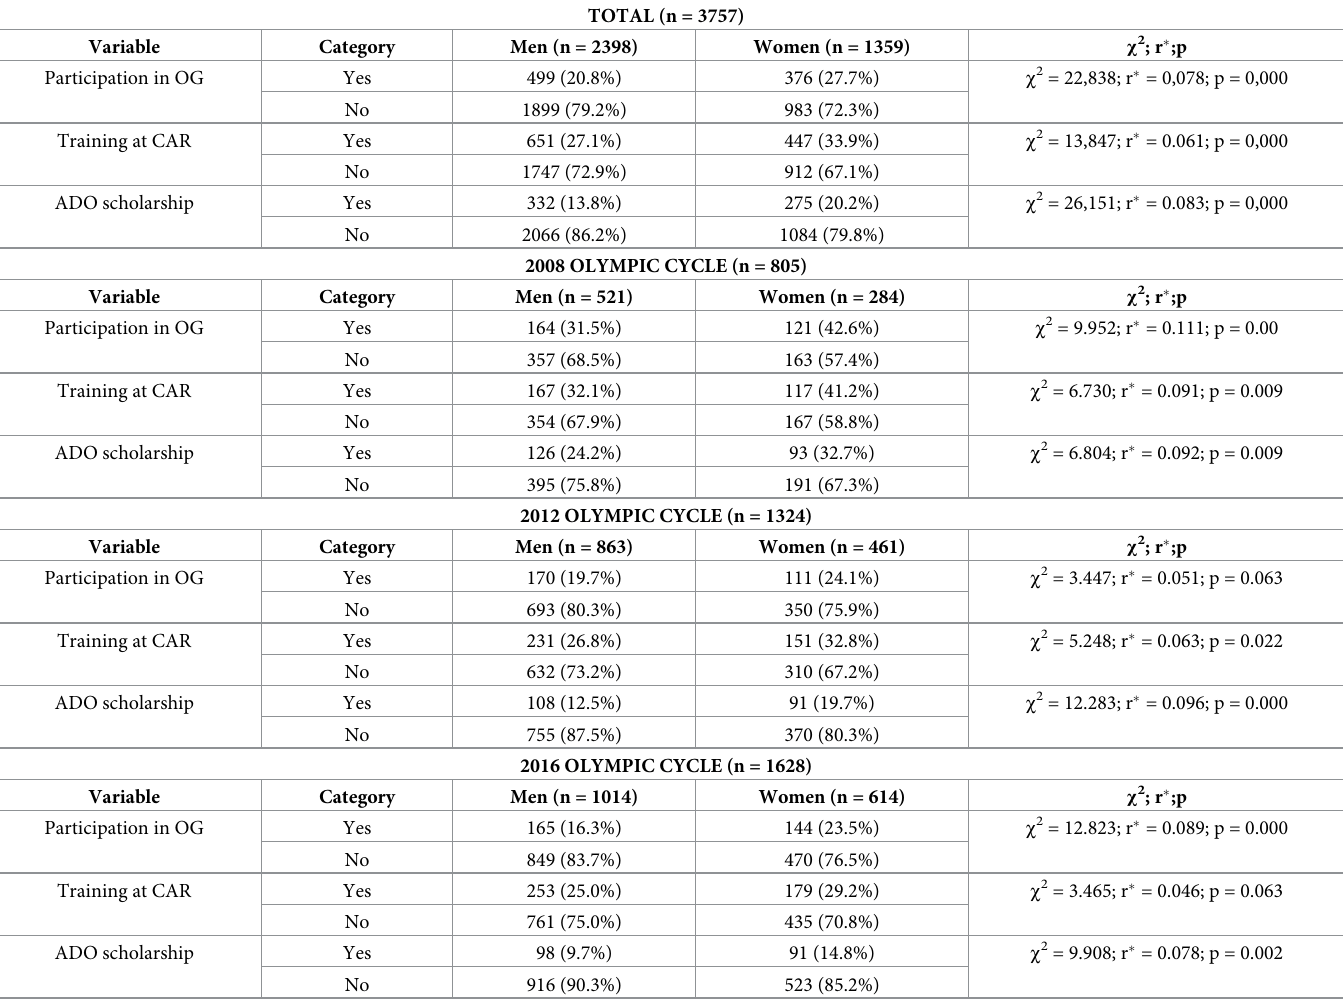
Table 1. Differences between males and females in participation in an OG, CAR training, and ADO plan scholarships, in general and according to Olympic cycles.